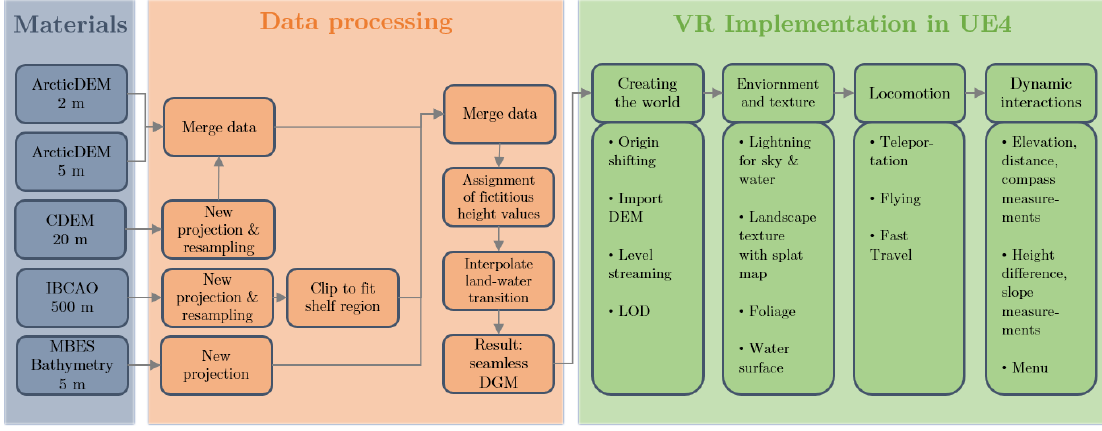
Figure 1. Workflow for the development of the virtual reality (VR) application.